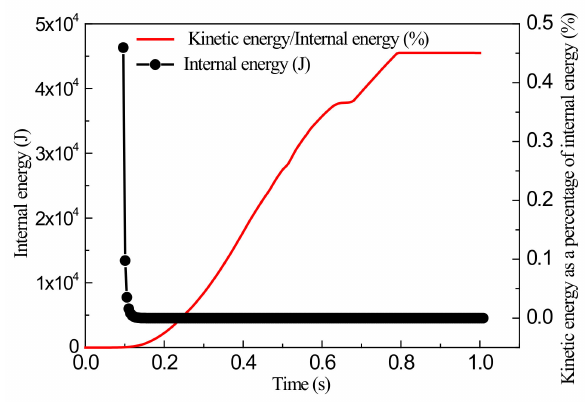
Figure 12. Variations of internal energy and ratio of kinetic energy to internal energy with